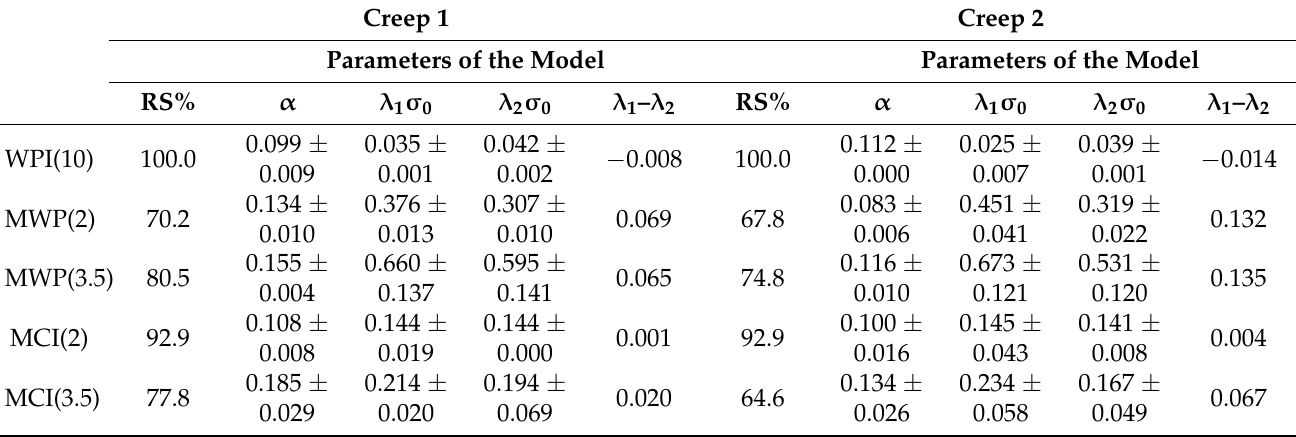
Table 3. % Recovery strain (RS) and fitting parameters for creep–recovery modeling of dairy protein emulsion gels ( α — derivative order; λ 1 σ 0 —creep constant; λ 2 σ 0 —recovery constant), for applied stress: 1 Pa. Given are parameter averages of the least square modeling of two creep–recovery cycles ± std.